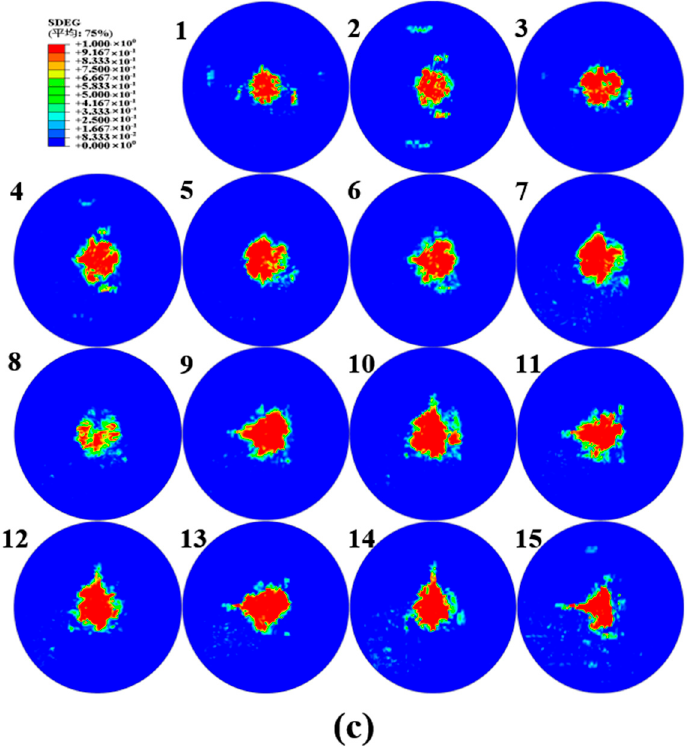
Figure 13. Delamination area of the UACS composite laminates under impacts at ( a ) 4 J, ( b ) 7 J and ( c ) 11 J.